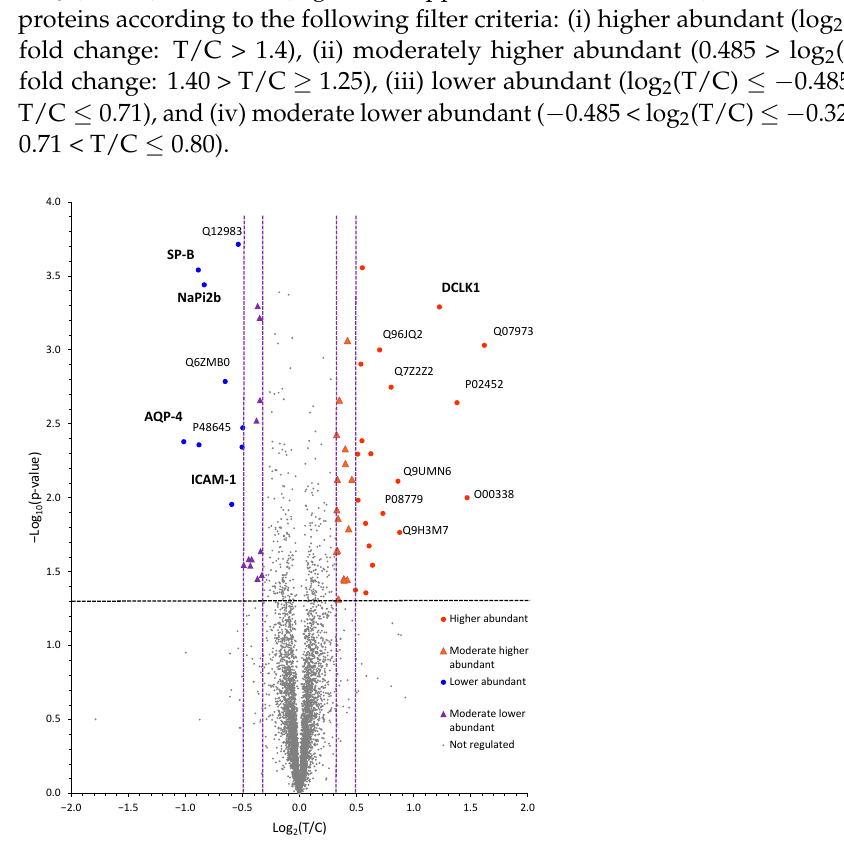
Figure 7. Protein abundance changes quantified by isobaric labeling and LC-MS/MS upon treatment of H44 cells with VD 3 . The volcano plot shows the relative changes of protein abundances: x-axis: log 2 treatment (T) vs. control (C), the values correspond to the T/C values shown in Supplemental Tables S1–S4 y-axis: log 10 ( p -value). Values above the horizontal dashed line are significant ( α = 0.05). Protein abundance changes are classified into four groups: lower abundant; moderately lower abundant; moderately higher abundant; and higher abundant (indicated by vertical dashed lines from left to right). Differentially abundant proteins are annotated by colored labels, naming according to protein identifiers or abbreviations (Supplemental Tables S1–S4; for reasons of readability, only selected proteins are